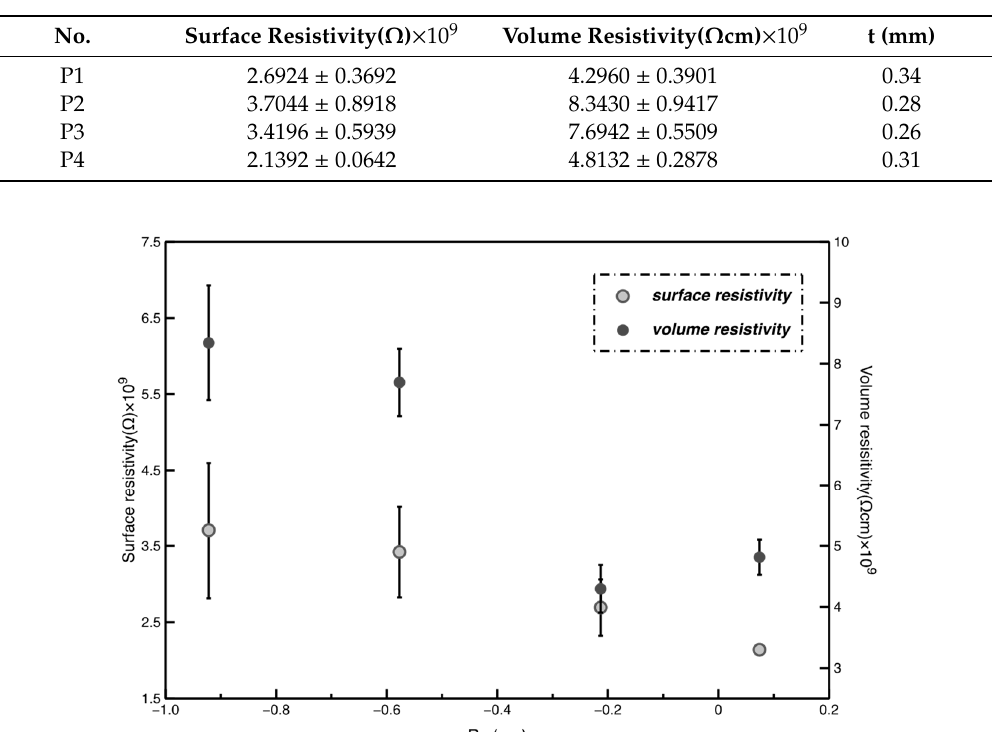
Figure 10. Relationship between resistivity and R sk .